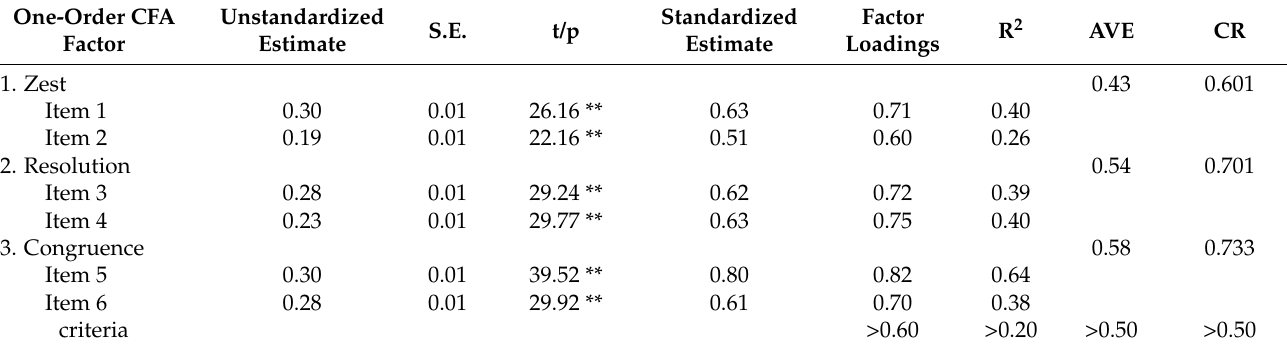
Table 4. Reliability and convergent validity of the